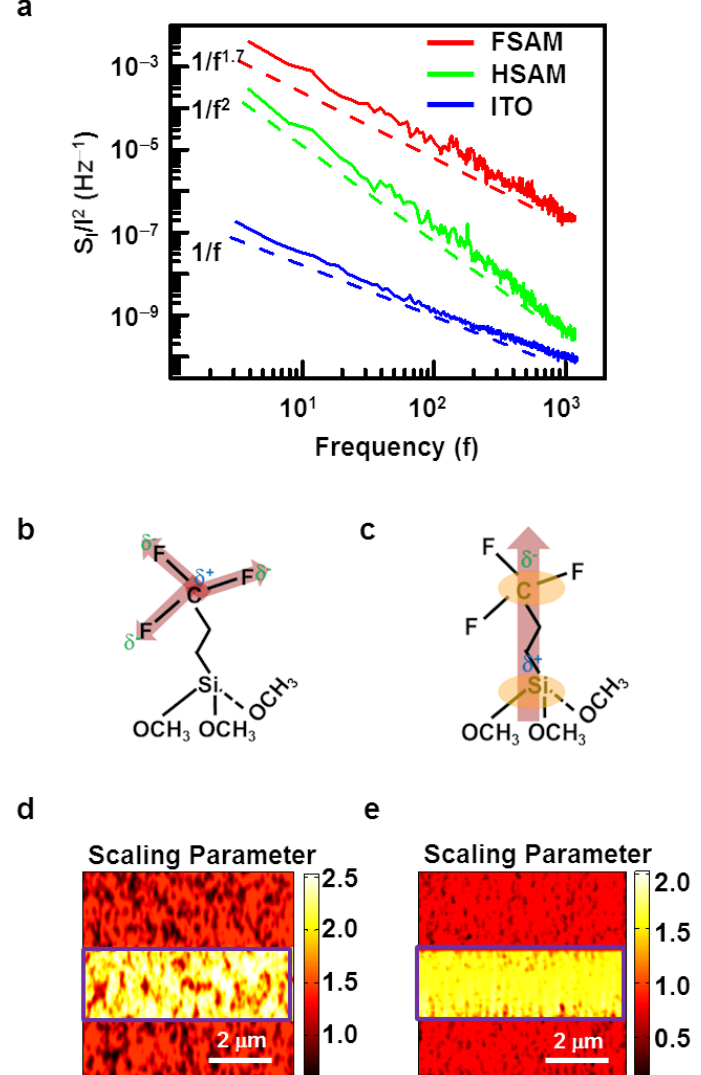
Figure 3. The frequency dependence of noise PSD and its scaling behavior in HSAM and FSAM. ( a ) Noise PSD as a function of frequencies in HSAM, FSAM, and ITO. HSAM exhibited 1/ f 2 behavior supposedly due to bond fluctuations. FSAM showed a weaker dependence like PSD ~1/ f 1.7 , which can be attributed to the effect of dipole fluctuations. The ITO shows typical 1/ f behavior commonly observed on a bulk film. ( b ) A schematic diagram of the bond polarization of FSAM molecule. Due to high electronegativity of fluorine, bonds are strongly polarized. ( c ) A schematic diagram showing backbone polarization of the FSAM. ( d ) A scaling parameter map of noise PSD spectra measured on HSAM (bright regions). HSAM showed a scaling parameter of 2. ( e ) A scaling parameter map of noise PSD spectra measured on FSAM (bright regions). FSAM regions showed scaling parameter of 1.7.